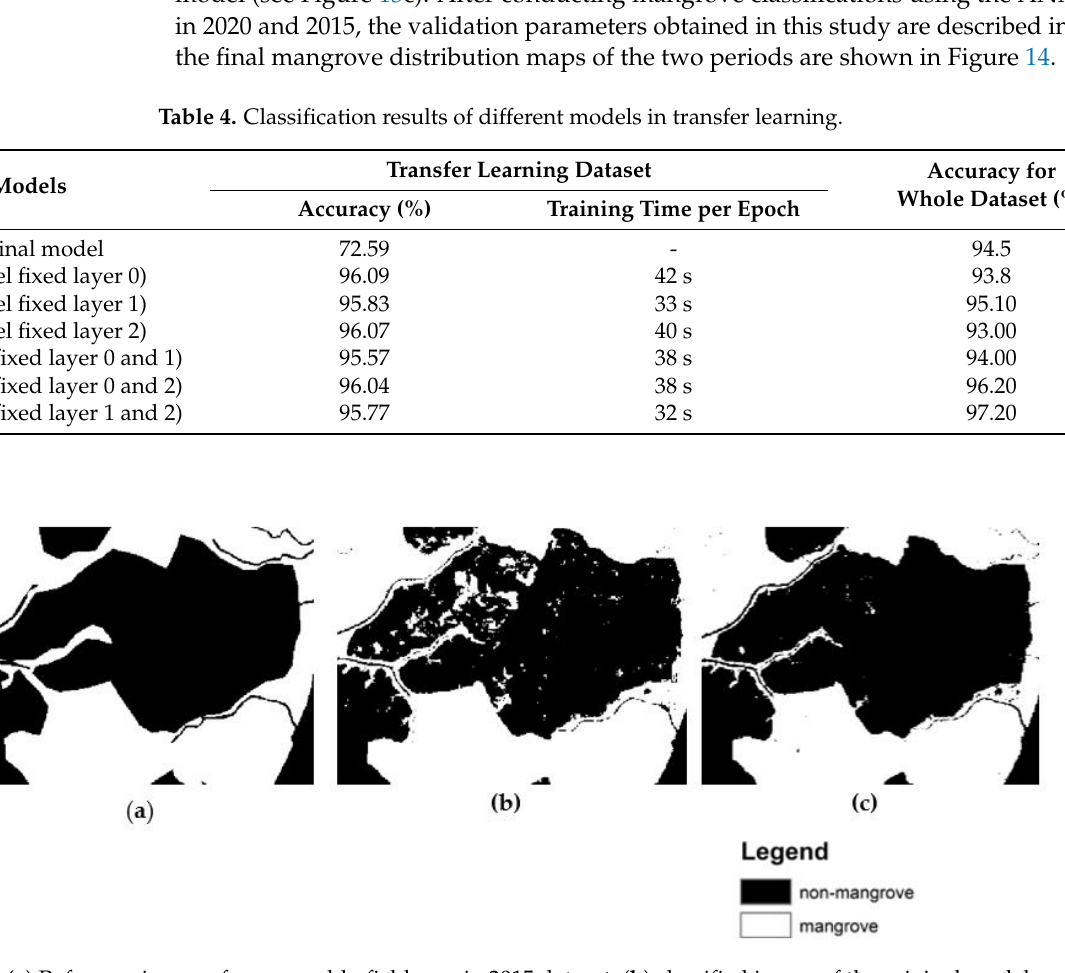
Figure 13. ( a ) Reference image of green paddy field area in 2015 dataset, ( b ) classified image of the original model and ( c ) classified image of T12 model. Table 5. Accuracy, kappa, precision, recall, and F1 scores and statistical significance (Z-test) assessment of ANN model for mangrove classification.